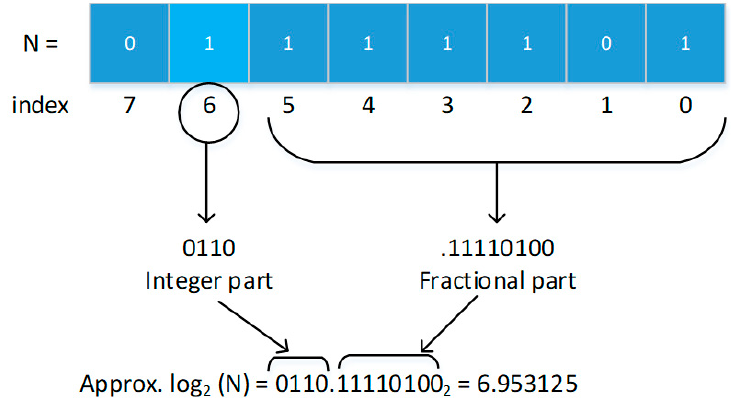
Figure 10. Parallel architecture design for a 2D convolution module.